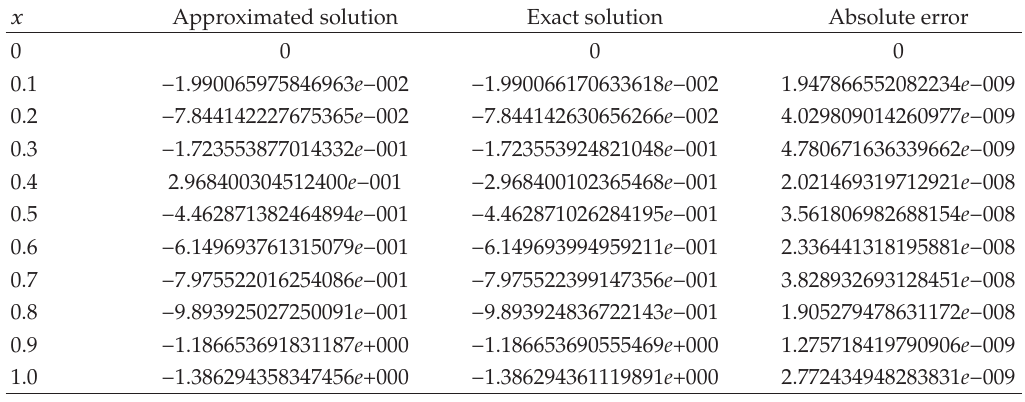
Table 2: Absolute error of Example 5.3 (cid:2) s exact and approximated solution.